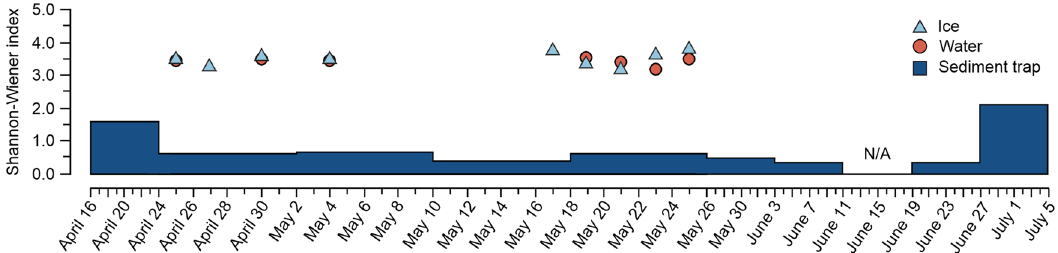
Fig. 6 Diatom species diversity in sea ice, water column and sediment trap samples. Shannon-Wiener diversity indices for sea ice (light blue triangle), water column (orange circle) and sediment trap (dark blue silhouette) samples during the